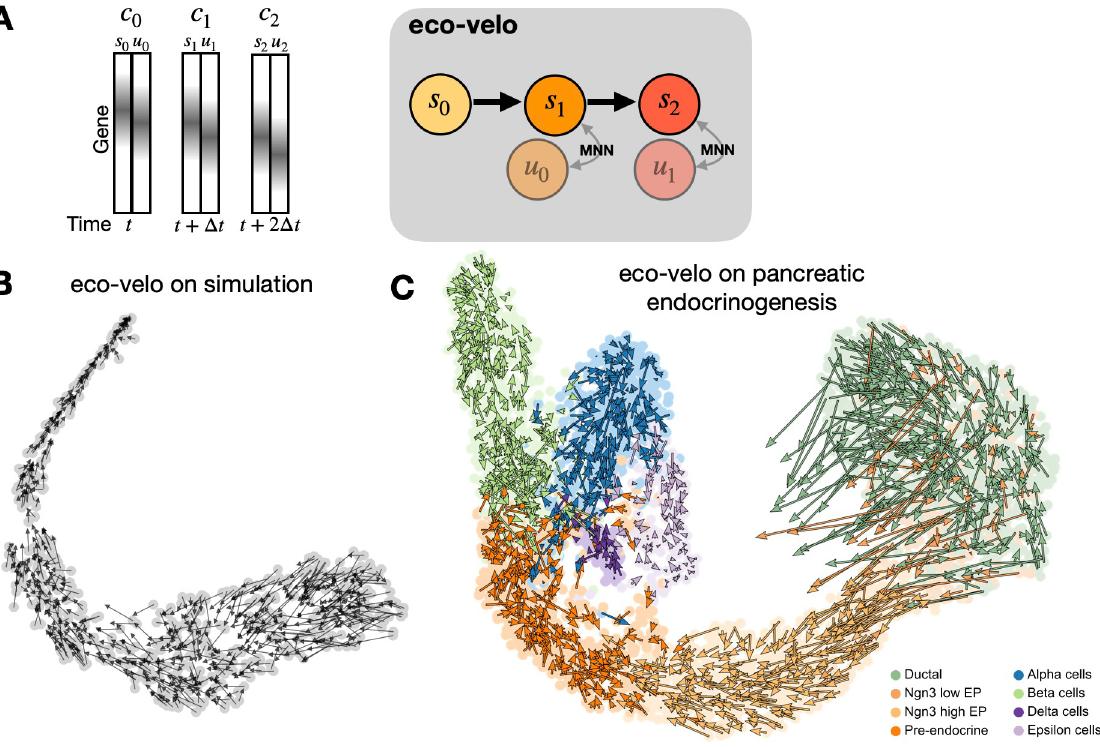
Fig 6. Eco-velo as an alternative to computationally costly reaction rate parameter recovery. A . Under certain conditions, a cell’s unspliced state will represent the cell’s future spliced state. To infer velocities, we look for the first MNN between a cell’s unspliced counts and other cells’ spliced counts. We draw an arrow from the cell to the identified MNN. B . We validate eco-velo on simulation and visualise the resulting velocities on t-SNE. C . eco-velo on pancreas